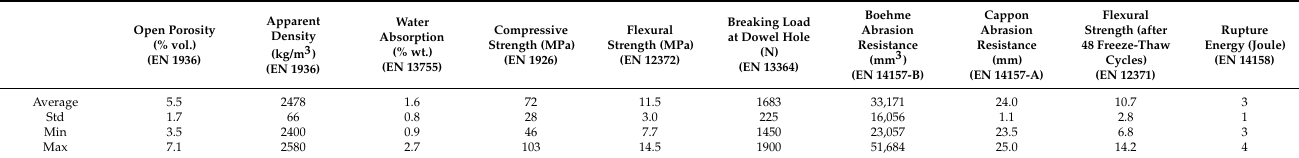
Table 5. Average values of physical mechanical properties determined for